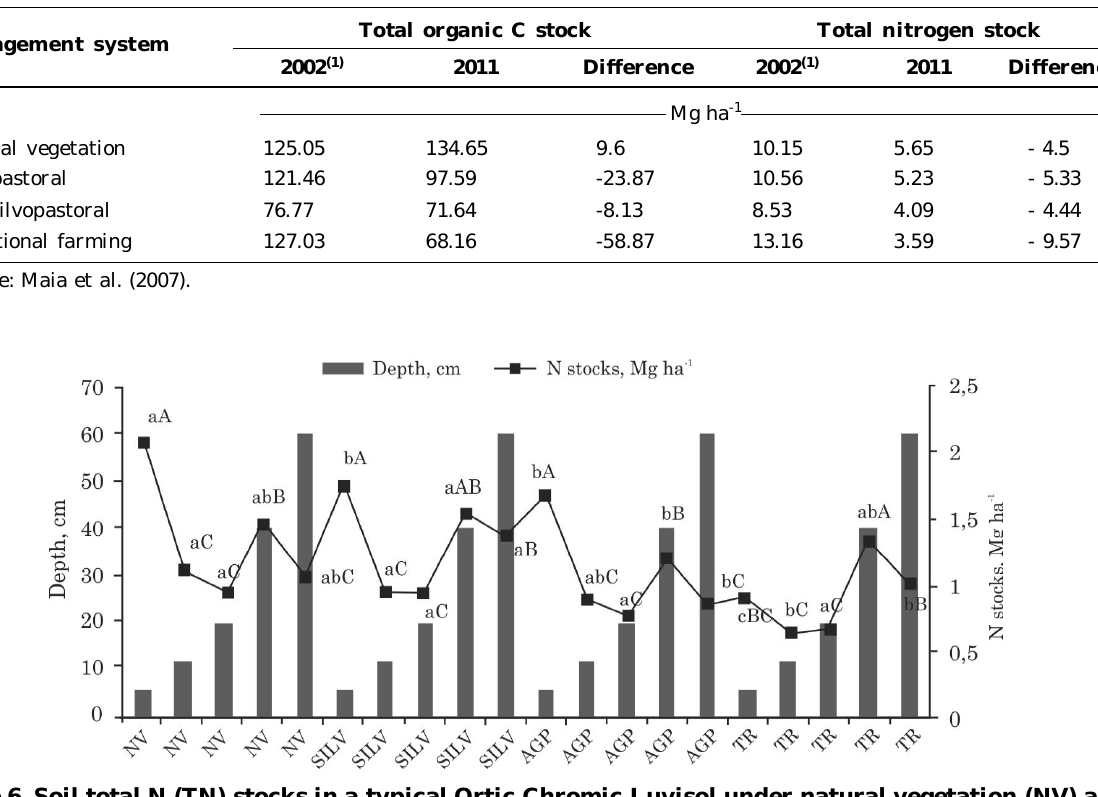
Figure 6. Soil total N (TN) stocks in a typical Ortic Chromic Luvisol under natural vegetation (NV) and silvopastoral (SILV), agrosilvopastoral (AGP) and traditional agricultural (TR) systems after 13 years of soil cultivation in Sobral, Ceará. Means followed by similar letters do not differ by Tukey’s test at 5 %; uppercase letters compare the layers in each area and lowercase letters compare the areas in each